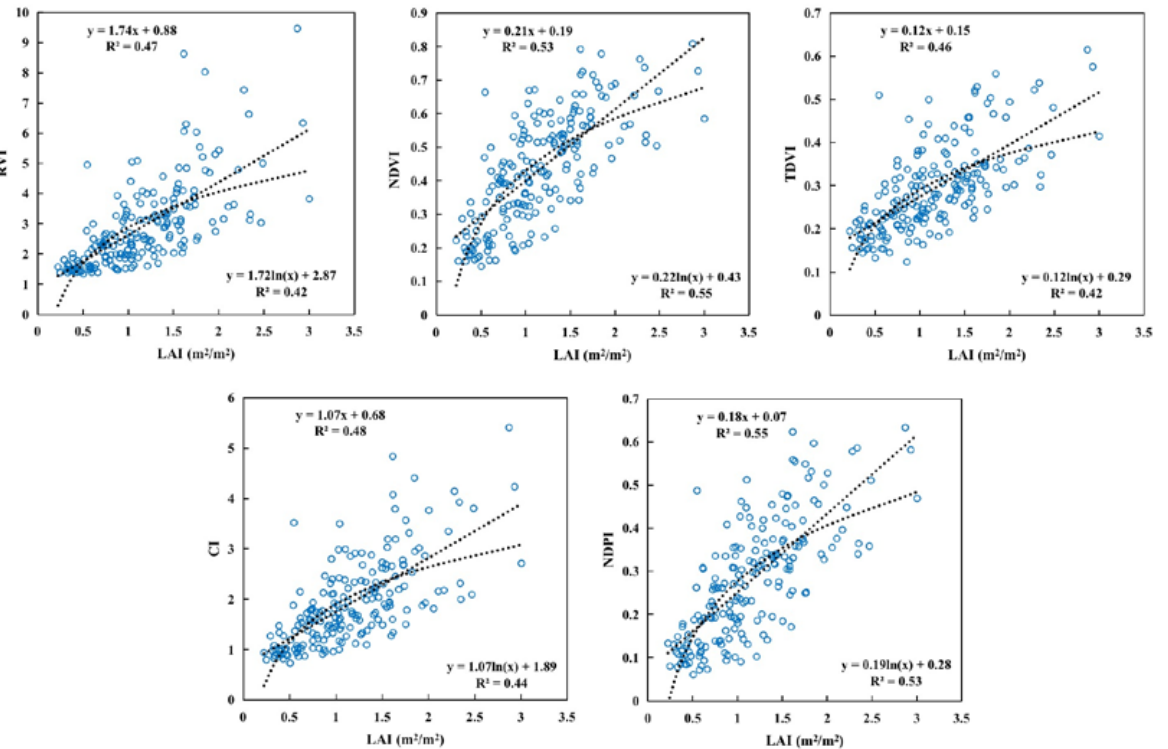
Figure 9. Linear and logarithmic relationships between the in situ measured LAI and vegetation indices using all sample plots.